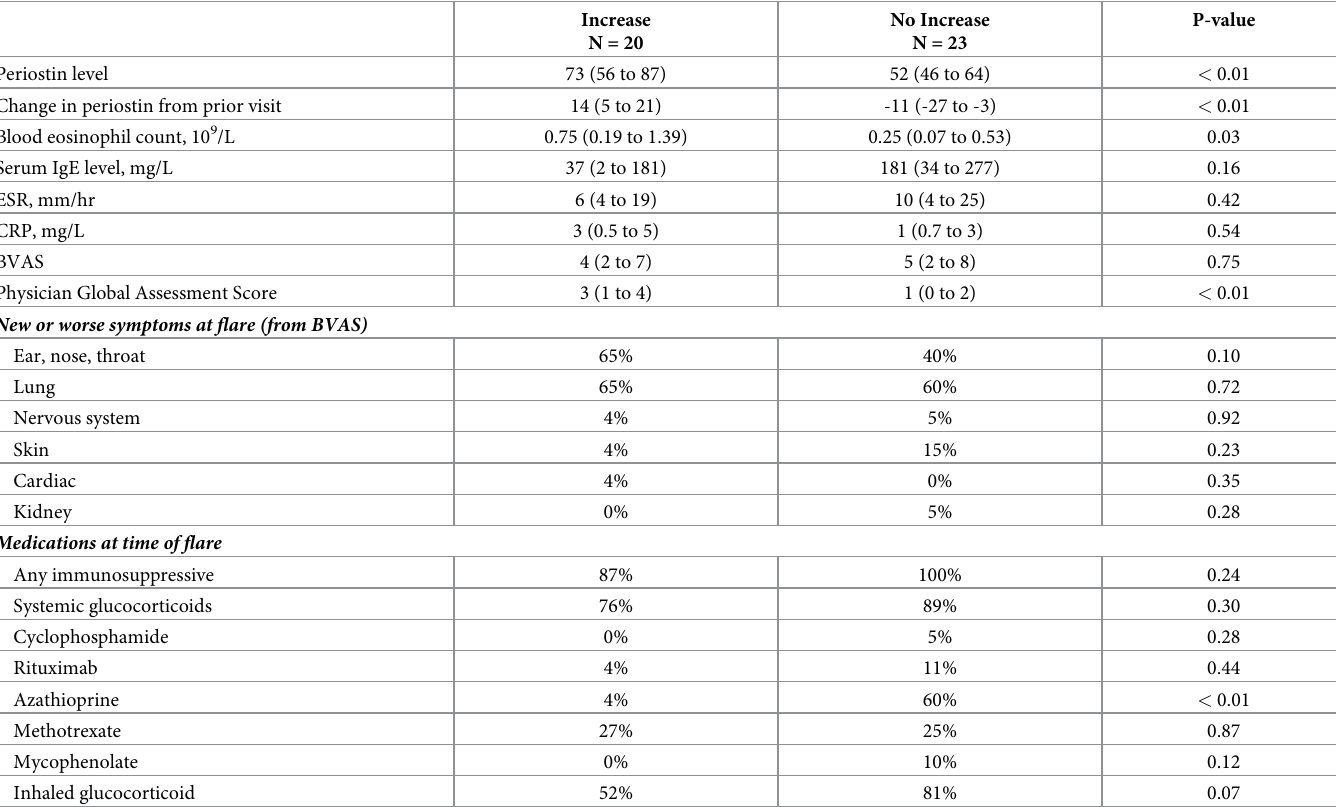
Table 3. Characteristics of patients with eosinophilic granulomatosis with polyangiitis during flare visits stratified by increase or no increase in serum periostin compared to prior visit �